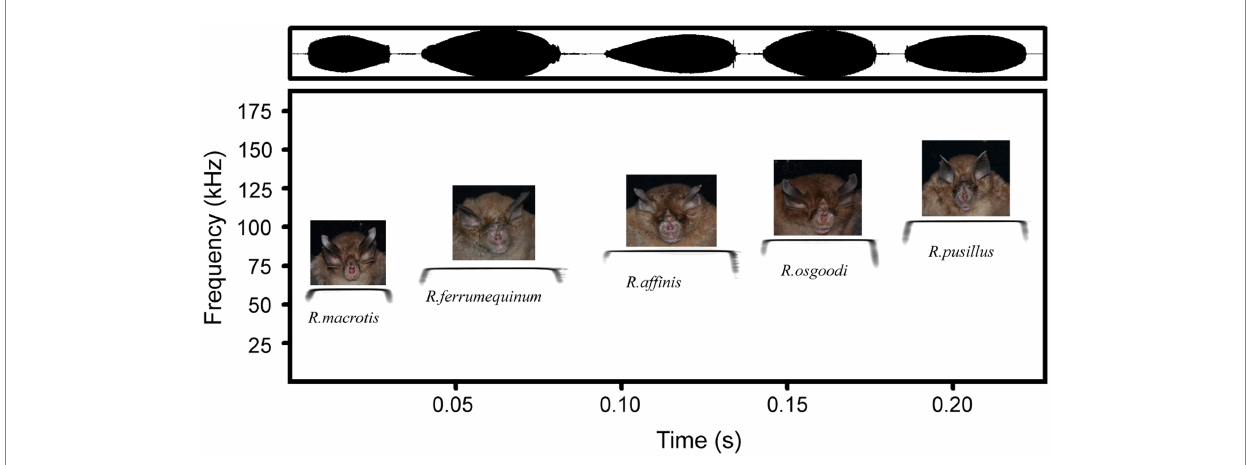
FIGURE 3 Sound envelopes (top) and acoustic spectrograms (bottom) corresponding to the peak frequencies of echolocation calls of five rhinolophid bats.